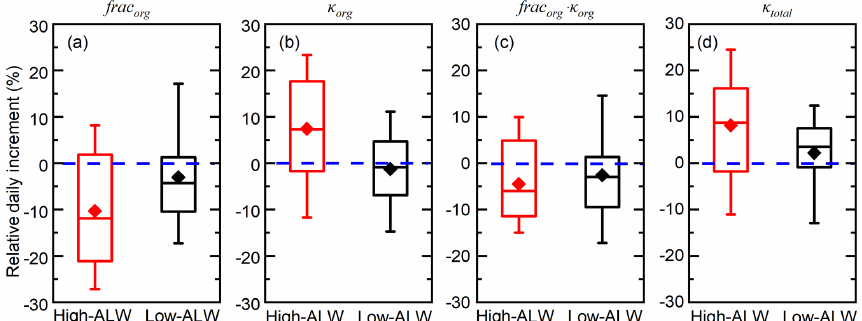
Figure 6. Episode-based relative day increment of organic hygroscopicity ( κ org ), organic volume fraction (frac org ), the hygroscopicity term contributed by organics ( κ org · frac org ), and overall particle hygroscopicity ( κ total ) during high-ALW haze episodes and low-ALW haze episodes. The box plots represent the 10th, 25th, 50th, 75th, and 90th percentiles of the corresponding data. The rhombus represents the mean value of the corresponding data.